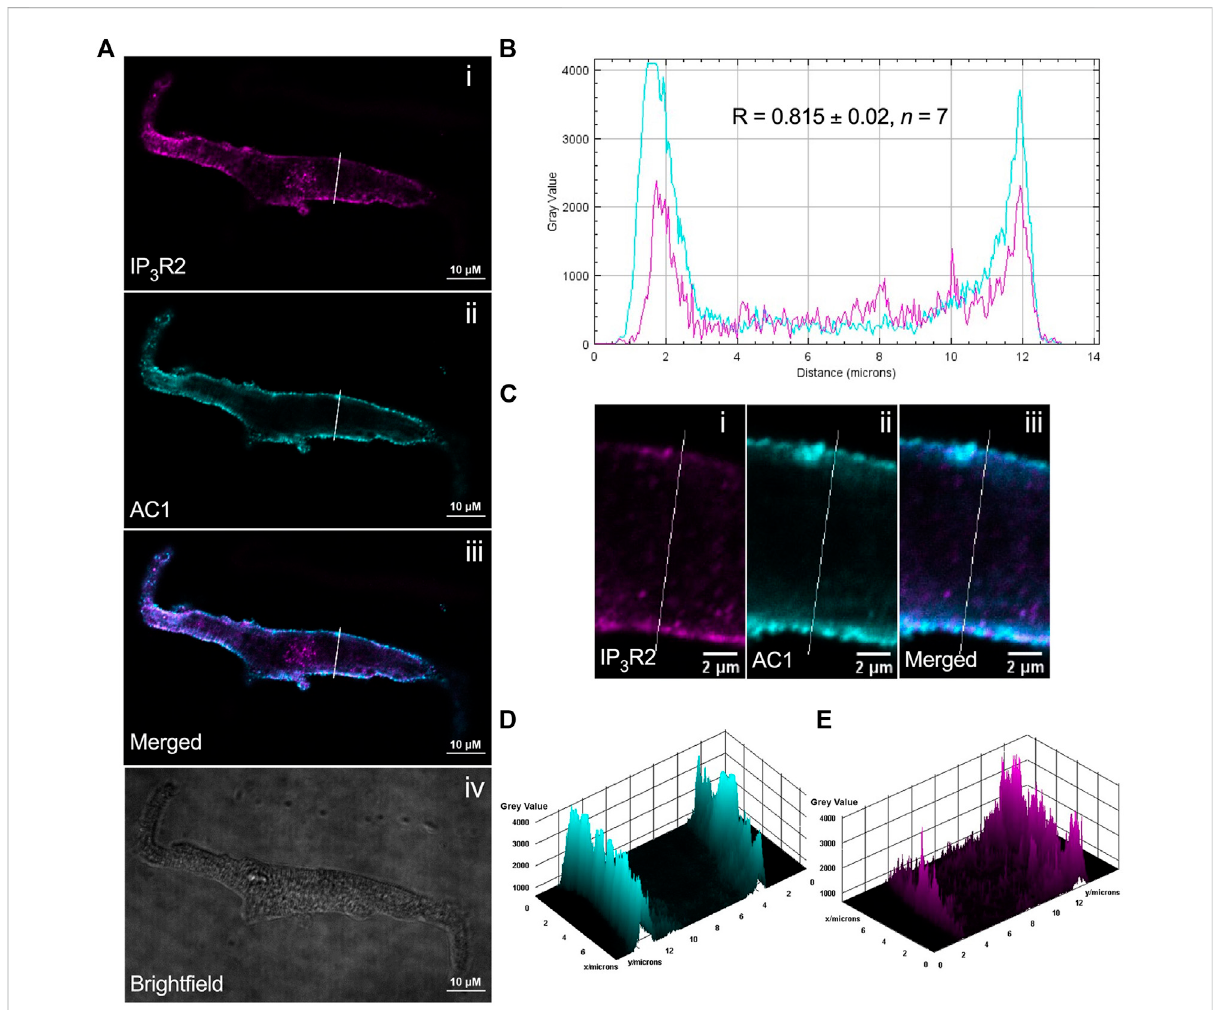
FIGURE 2 IP 3 R2 is expressed in close proximity with AC1 in guinea pig SAN myocytes. (A) Representative example of a fi xed, isolated guinea pig SAN myocyte immunolabelled for (i) IP 3 R2 (magenta), (ii) AC1 (cyan), (iii) co-immunolabelled for IP 3 R2 (magenta) and AC1 (cyan). Example bright fi eld image shown in (iv). (B) Intensity plot to show staining intensity along the white line shown in (A) . R-value calculated from n = 7 cells. (C – E) Intensity surface plots showing the distribution of staining of IP 3 R2 [magenta, (D) ] and AC1 [cyan, (E) ] for the regions of cell shown in (C) . Scale bars representing 10 µm are indicated in (A) and 2 µm in (C) . For the purposes of presentation only, red and green channels have been represented as magenta and cyan,